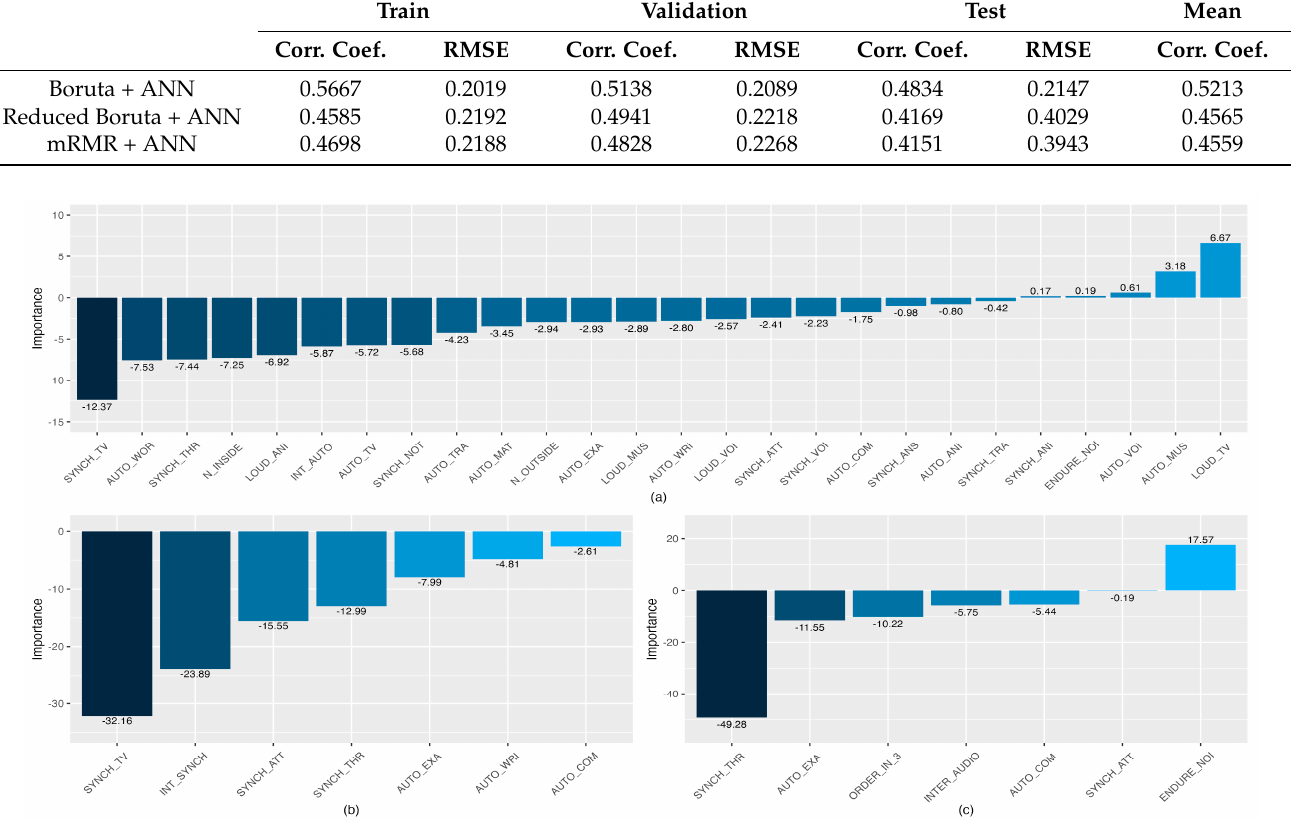
Figure 8. Percentage of the relative importance of the predictors of the ANNs on students’ satisfaction, calculated with the Olden et al. method [61]. The variables selected by Boruta ( a ), mRMR ( c ), and the set of reduced Boruta variables ( b ) were used as predictors. Values higher than zero mean positive relative contribution, and those lower than zero mean negative relative contribution.